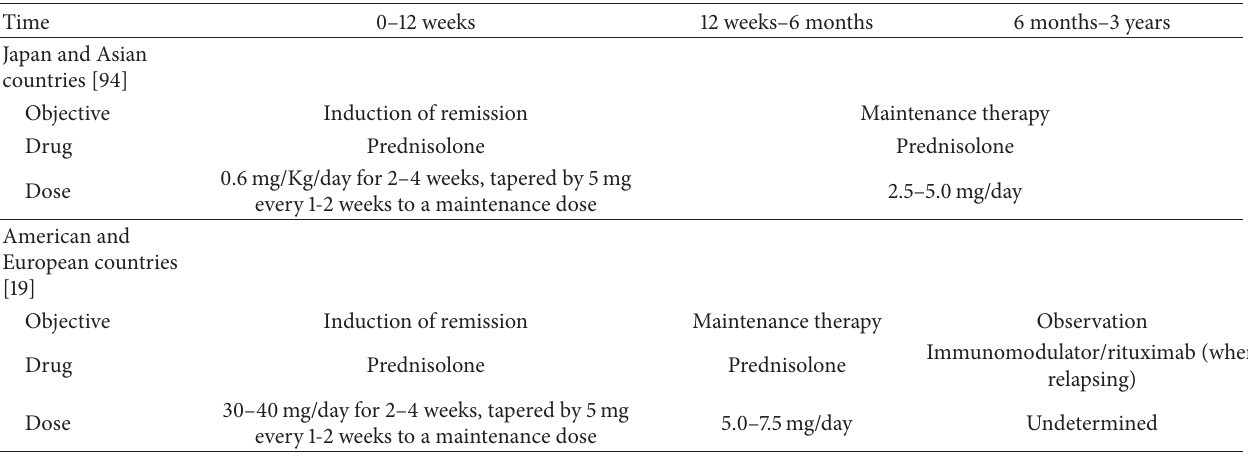
Table 6: Management strategy of AIP based on immunology